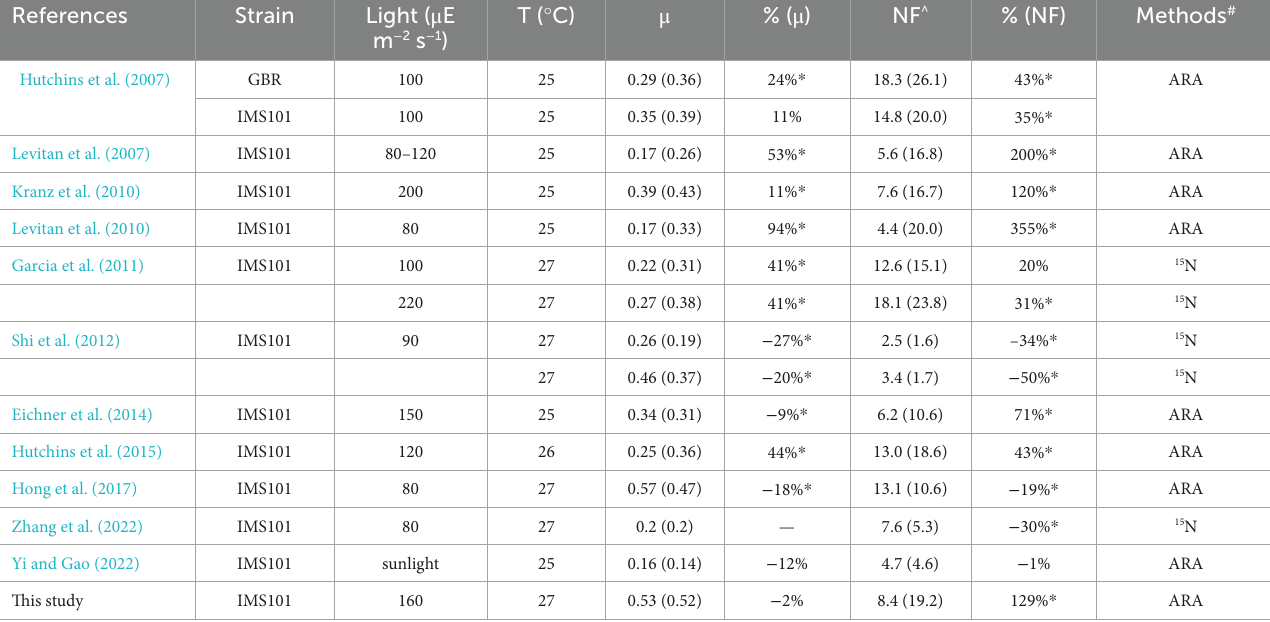
TABLE 2 Documented growth rates ( μ ) and nitrogen fixation rates (NF) of T. erythraeum grown under low (350 ~ 400 μ atm) and high (750 ~ 1,400 μ atm, values in the brackets) CO 2